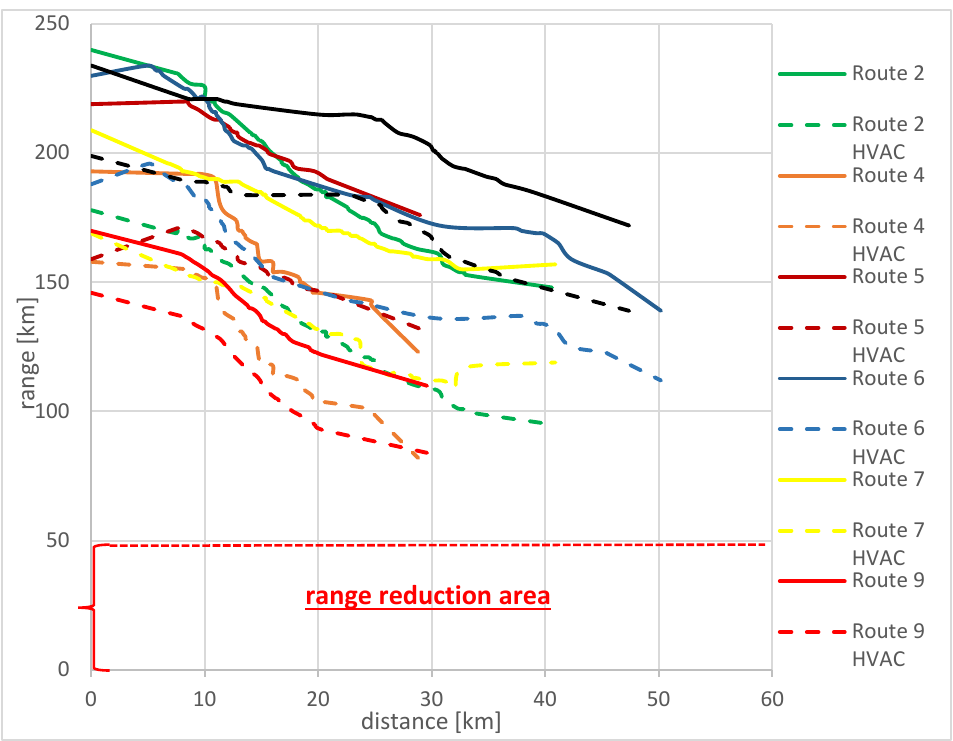
Figure 6. Comparison of ranges with switched on and off receivers. Source: Own study.